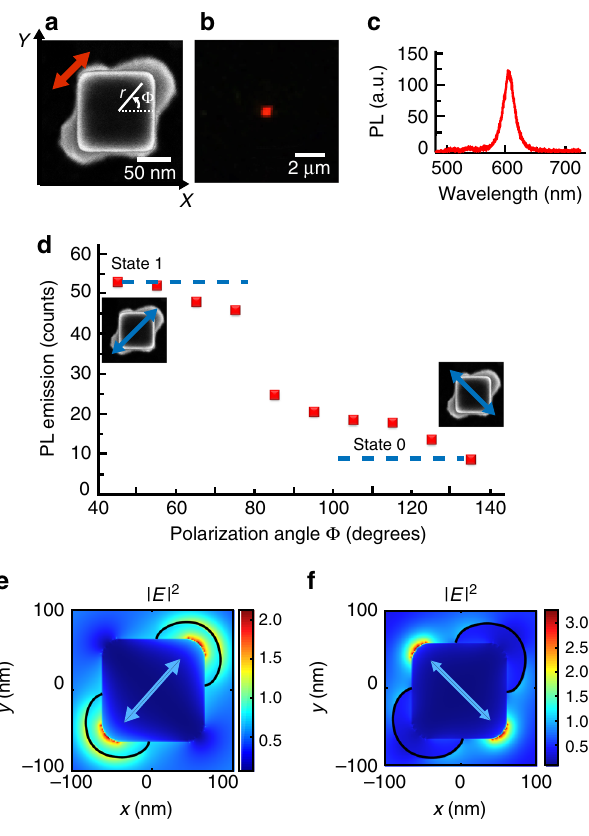
Fig. 3 Photoluminescence measurements on hybrid nano-emitters. Single hybrid nanosource based on a Au nanocube and CdSe/CdS/Zn quantum dots embedded within nanometric polymer lobes obtained by plasmonic 2- photon polymerization under ϕ = 45° linear excitation (red arrow). a SEM image of the hybrid plasmonic nanosource with polar coordinates used for discussion. The initial bare nanocube is superimposed to the raw SEM image. b Far- fi eld PL image at polarization angle ϕ = 45°, λ = 405 nm, linear polarization. c PL spectrum. d PL intensity as a function of the angle of polarization of the exciting blue beam. Blue arrows indicate two speci fi c perpendicular polarizations e , f Calculated near- fi eld intensity |E| 2 , λ = 405 nm, mid horizontal section planes, polarizations indicated by blue arrows. Black lines represent the contours of the polymer lobes as deduced from the SEM image ( a ).